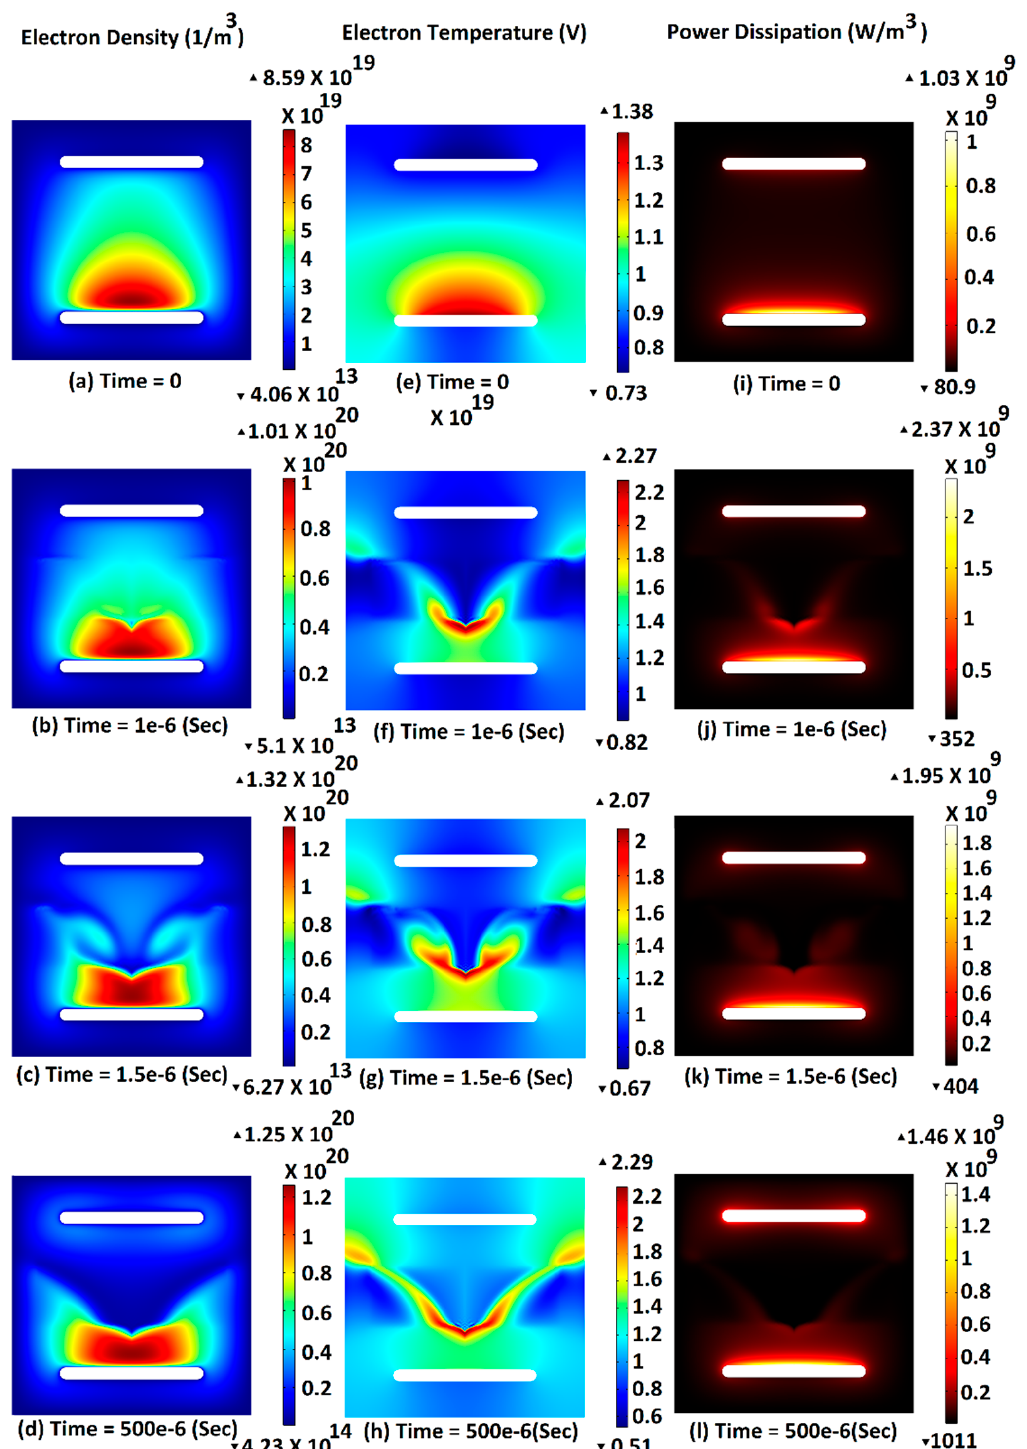
Figure 1. Distribution of electron, electron temperature, and power dissipation in plasma at different time steps: ( a , e , i ) initial moment, ( b , f , j ) 1 µSec, ( c , g , k ) 1.5 µSec and ( d , h , l ) 500 µSec after application of 20 mT ultrafast transverse magnetic field (UFTMF).